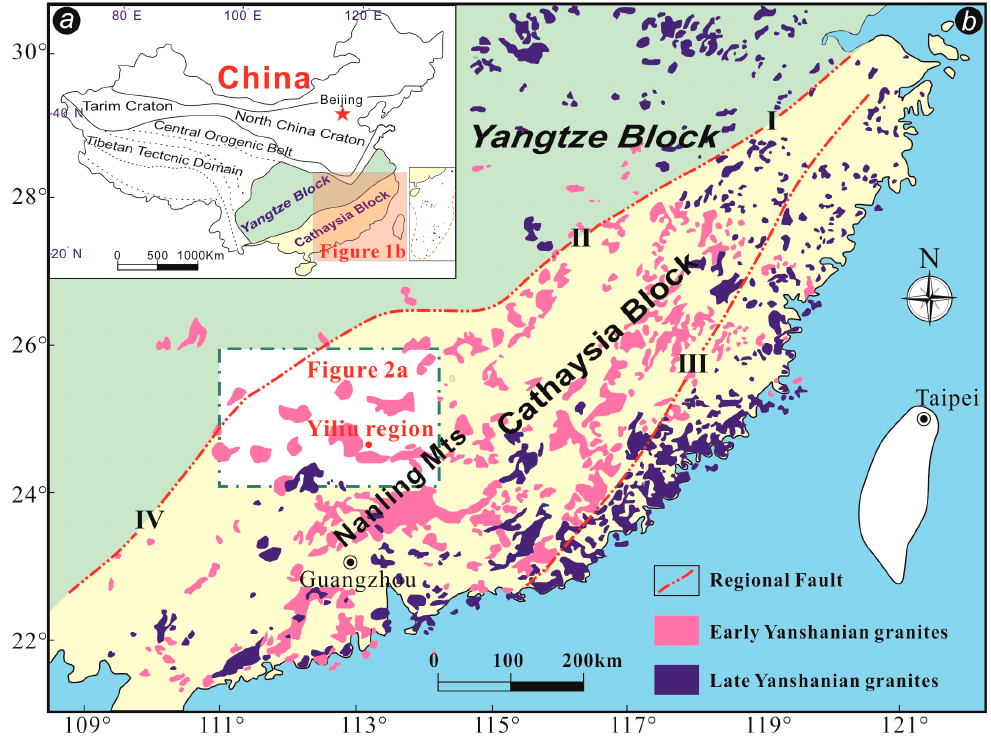
Figure 1. Geological sketch map of South China modified after Li et al. [11] and Li et al. [12], showing